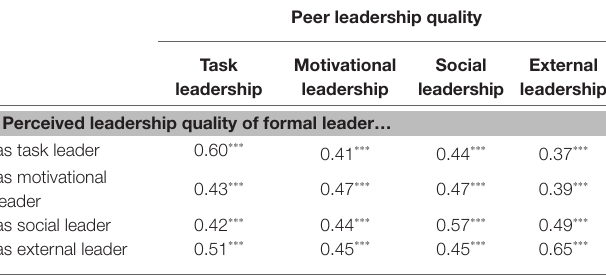
TABLE 3 | Correlations between PLQ of each leadership role and formal leadership quality.